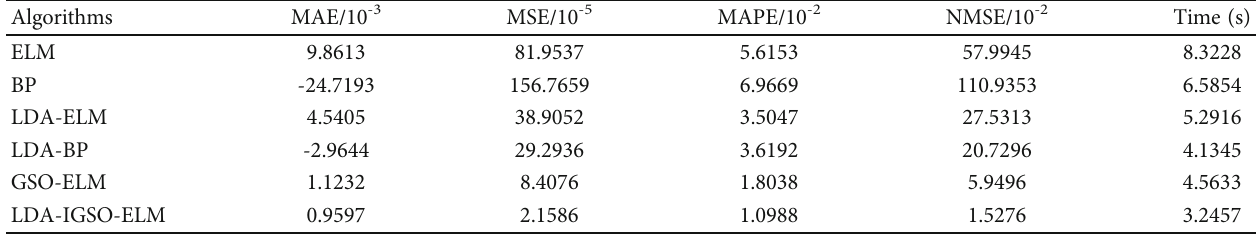
Table 5: Comparison of prediction errors of multiple